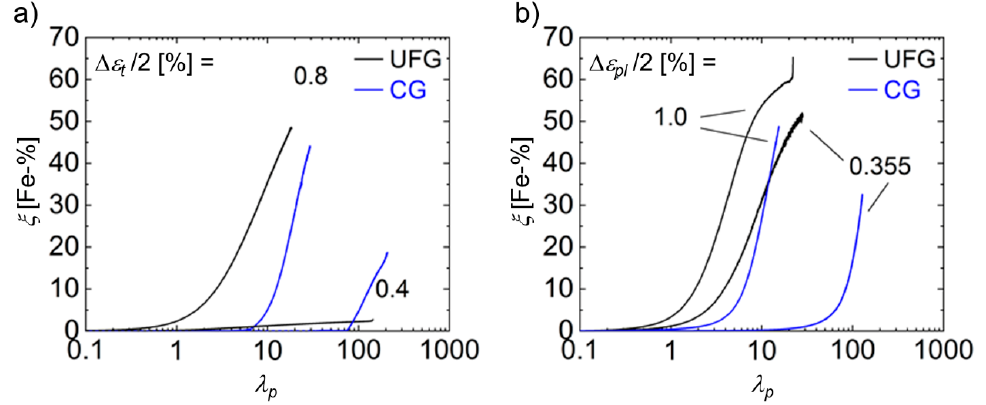
Figure 5. Evolution of ferromagnetic phase fraction as a function of cumulative plastic strain for UFG and CG material conditions during total strain ( a ) and plastic strain ( b ) controlled fatigue tests.